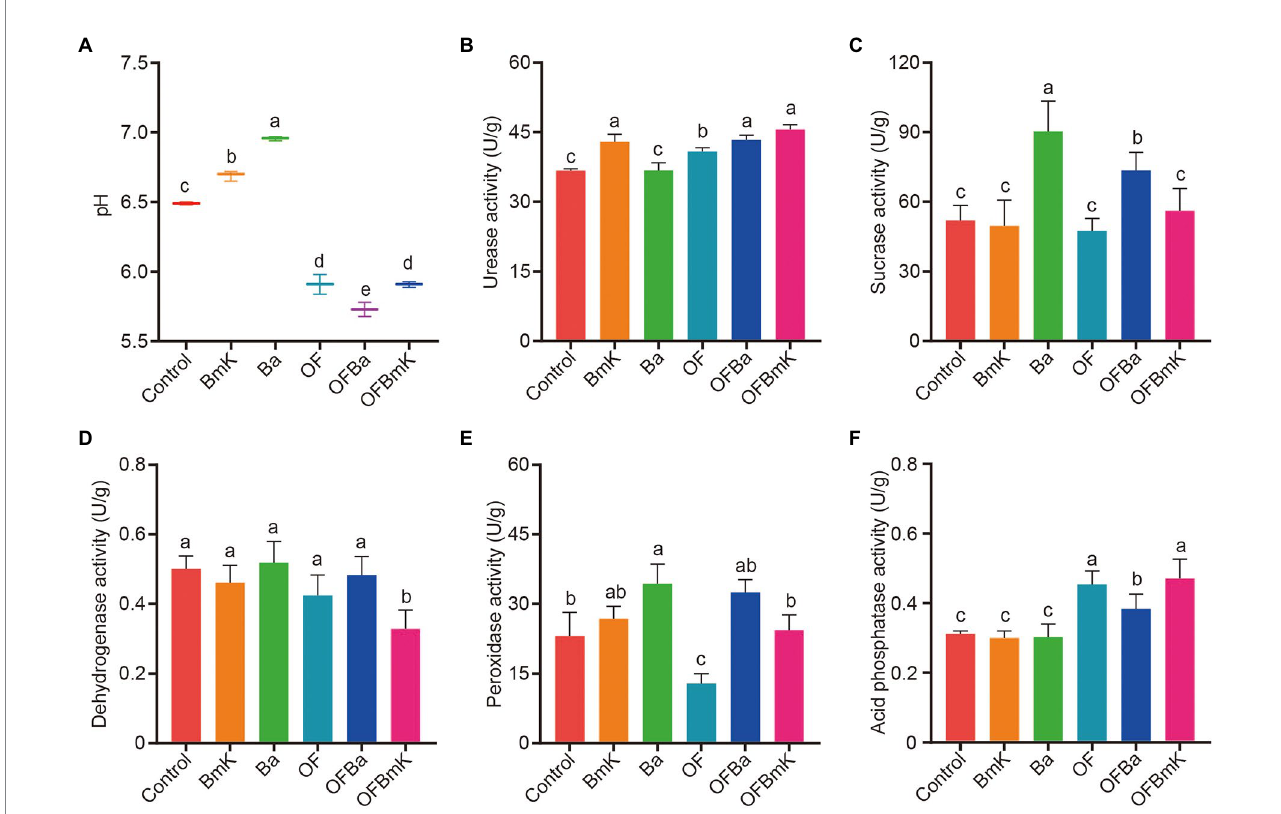
FIGURE 2 Effects of bio-organic fertilization on the pH and enzymatic activity in the soil. Soil pH (A) , urease activity (B) , sucrase activity (C) , dehydrogenase activity (D) , peroxidase activity (E) , and acid phosphatase activity (F) 90 days after the initiation of Dendrocalamus farinosus fertilization. One-way ANOVA and Tukey post-hoc test were used to calculate the differences between treatment groups; different letters represent significant differences between the mean values ( p < 0.05, n =